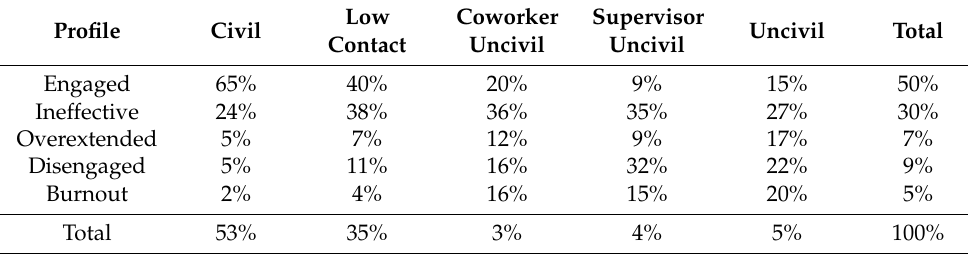
Figure 3. SES profiles and worklife profiles. Table 5. Relationship of social profiles with worklife